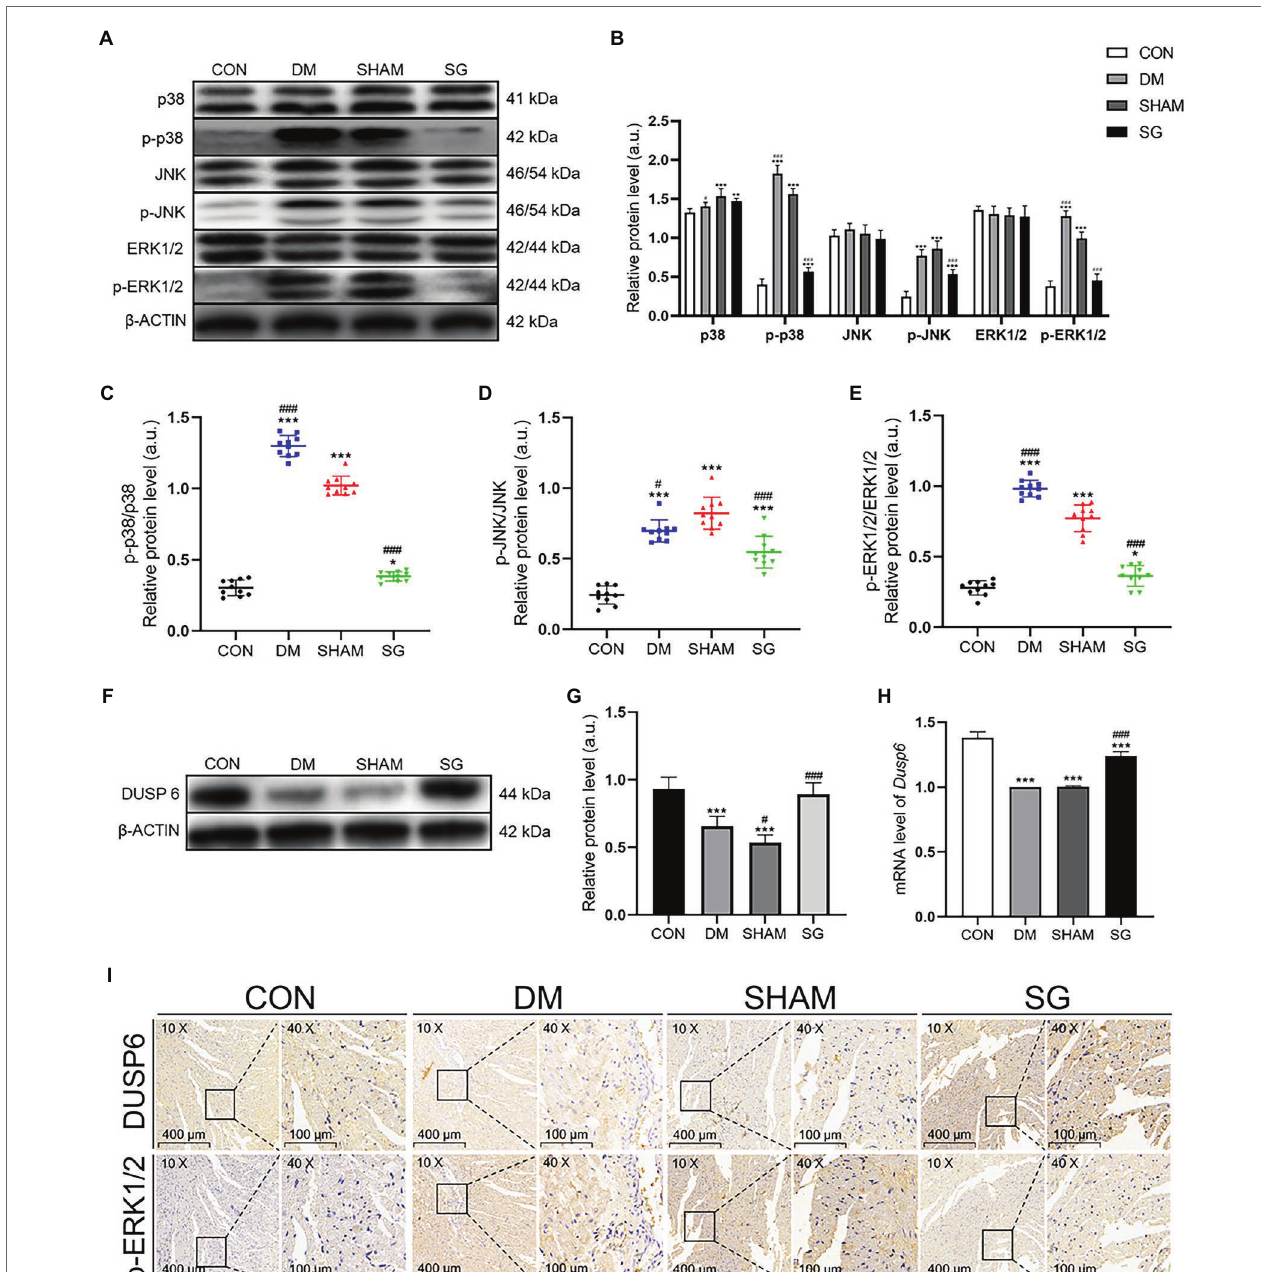
FIGURE 6 | The effect of SG on MAPK signaling pathway and the expression of DUSP6. (A) The representative bands of p38, p-p38, JNK, p-JNK, ERK1/2, and p-ERK1/2, and (B) relative protein level of p38, p-p38, JNK, p-JNK, ERK1/2, and p-ERK1/2 were quantitatively analyzed. (C–E) The expression ratio of p-p38 over total p38, p-JNK over total JNK, and p-ERK1/2 over total ERK1/2, respectively. (F) The representative bands of DUSP6 and (G) relative protein level of DUSP6 were quantitatively analyzed. (H) Cardiac mRNA level of Dusp6 was measured. (I) The representative immunohistochemical staining of DUSP6 and p-ERK1/2 (magnification 10×, scale bars represent 400 μ m; magnification 40×, scale bars represent 100 μ m). Brown staining is considered positive. Data are expressed as means ± SEM for n = 10 per groups. * p < 0.05 vs. CON group, ** p < 0.001 vs. CON group, *** p < 0.0001 vs. CON group; # p < 0.05 vs. SHAM group, ## p < 0.001 vs. SHAM group, ### p < 0.0001 vs. SHAM group. CON, control; DM, diabetes mellitus; SHAM, sham operation; SG, sleeve